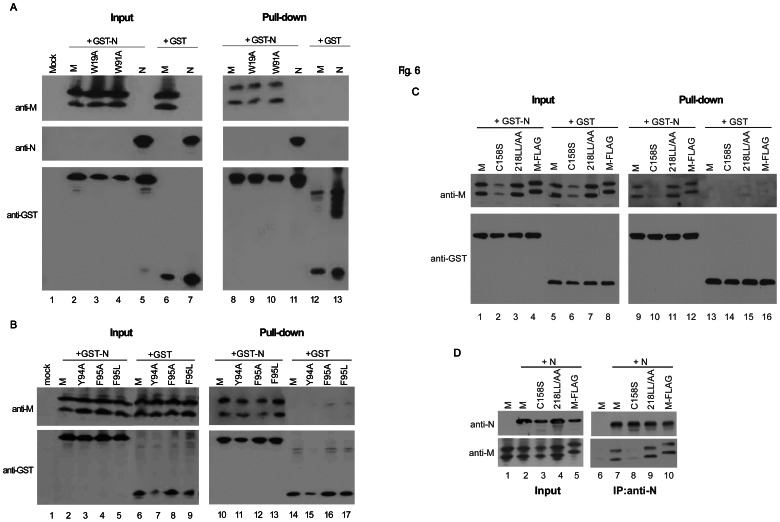
Co-precipitation of M mutants with SARS-CoV N.(A–C) GST pull-down assay. 293T cells were cotransfected with GST-N (SARS-CoV N fused to the GST carboxyl terminus) and N, wt or indicated M mutant plasmid. Aliquots of cell lysates preceding and flowing GST pull-down were subjected to Western immunoblotting using anti-GST, anti-M and anti-N antibodies as probes. (D) Co-immunoprecipitation assay. 293T cells were cotransfected with SARS-CoV N with the indicated wt or mutant M plasmid. Aliquots of cell lysates were subjected to co-immunoprecipitation with an anti-N monoclonal antibody.